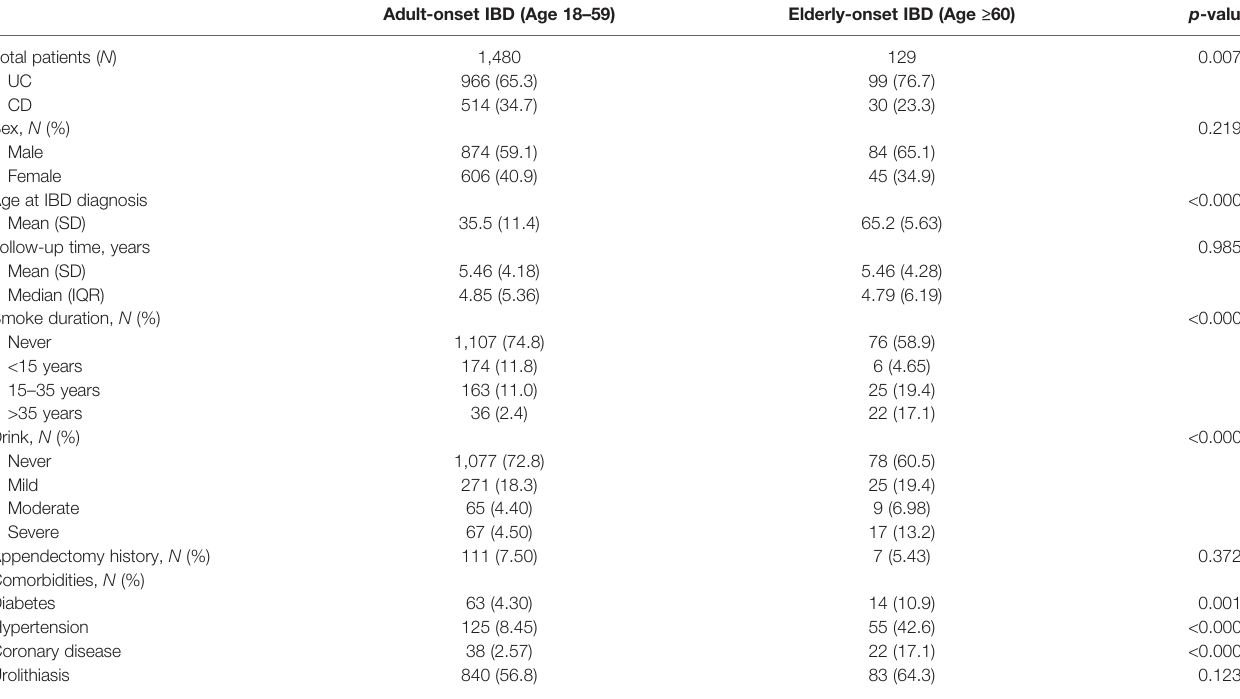
TABLE 1 | Patient characteristics of the